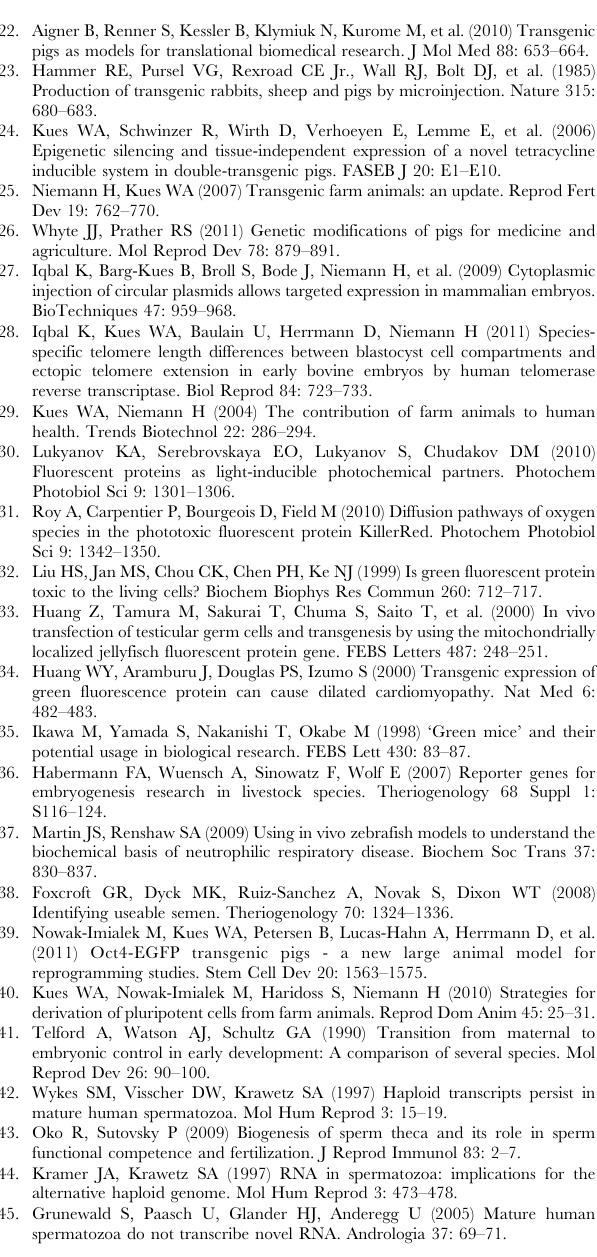
Table S1 Primer pairs used for RT-PCR. (DOC) Video S1 Venus fluorescent spermatozoa. Freshly isolated spermatozoa from boar # 505. The start sequence shows the spermatozoa under brightfield conditions, followed by specific excitation of the Venus fluorophore. Note, several